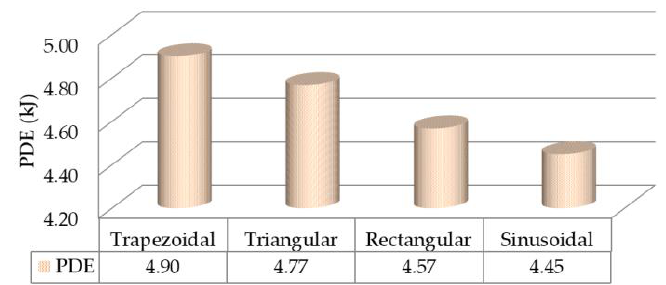
Figure 11. The effect of corrugation shape/topology on the plastic dissipation energy of the sandwich panel, when subjected to 0.5 kg of TNT at R = 0.5 m (BI-5).